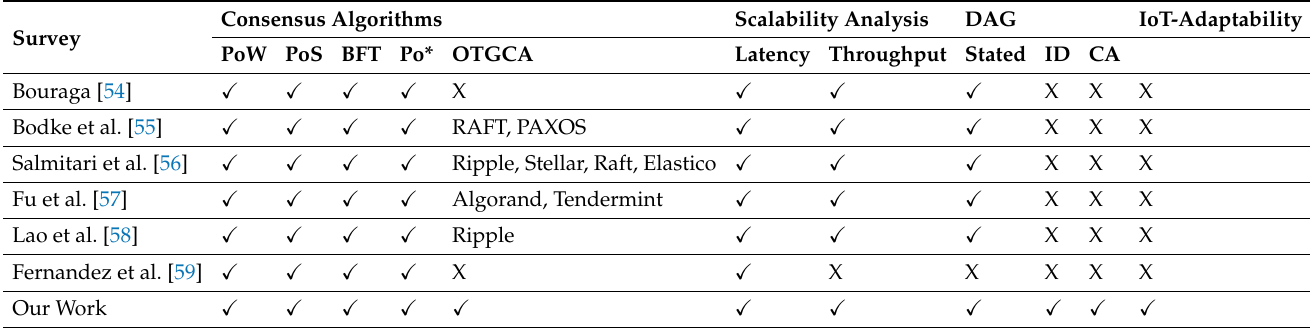
Table 1. Related Surveys on